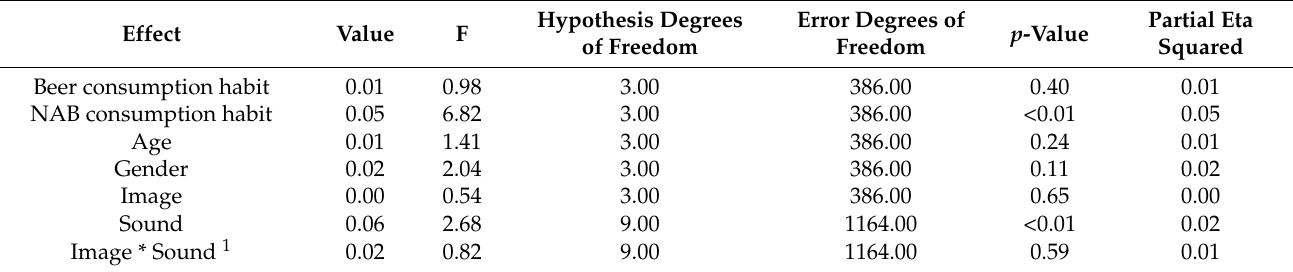
Table 7. Summary of the results of the Pillai’s Trace multivariate tests for the sensory scores in Experiment 2.